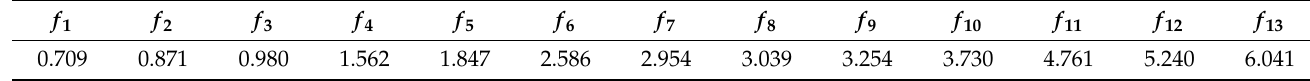
Table 2. The frequencies (Hz) of the first 13 modes of the dynamic model of the slewing superstructure.